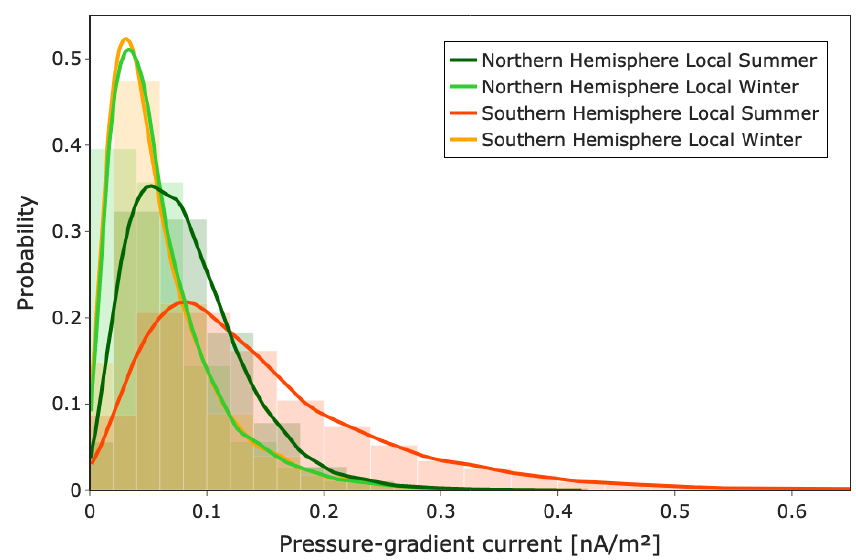
Figure 8. Distributions of the pressure-gradient current values for local summer and local winter conditions in the Northern and Southern hemispheres. Solid line represents the continuous probability density curve and is plotted above the more transparent relative